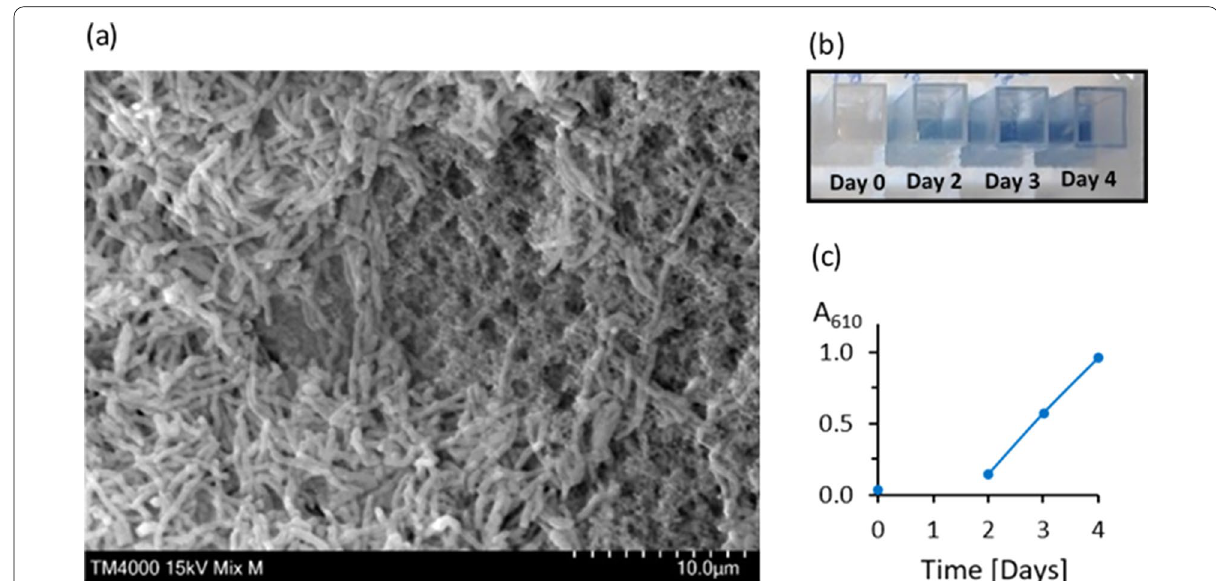
Fig. 4 a SEM of MAETAC monomers revealing bacterial biofilm adhered onto 3D printed support after 3 days of incubation with R. opacus culture in exponential growth phase. BT is desulphurized by R. opacus into phenolic end products, as detected using Gibbs test on perfusate samples visualized by blue colour ( b ) and measured at 610 nm ( c